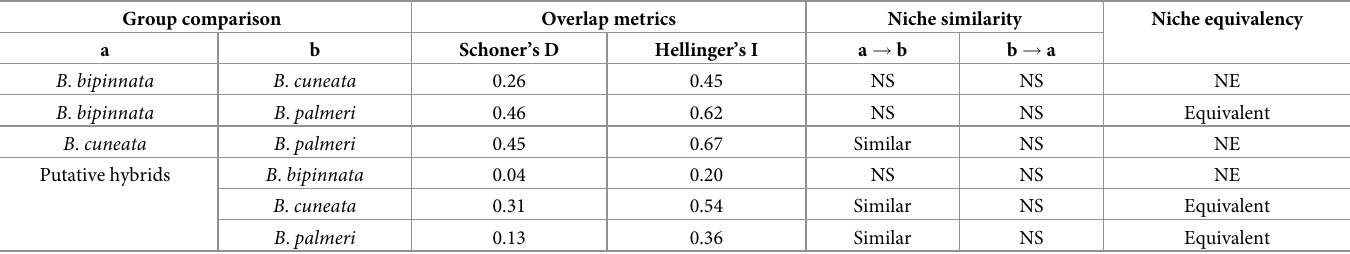
Table 3. Pairwise niche overlap values of Schoener’s D and Hellinger’s I between the three Bursera species and their putative hybrids. Group